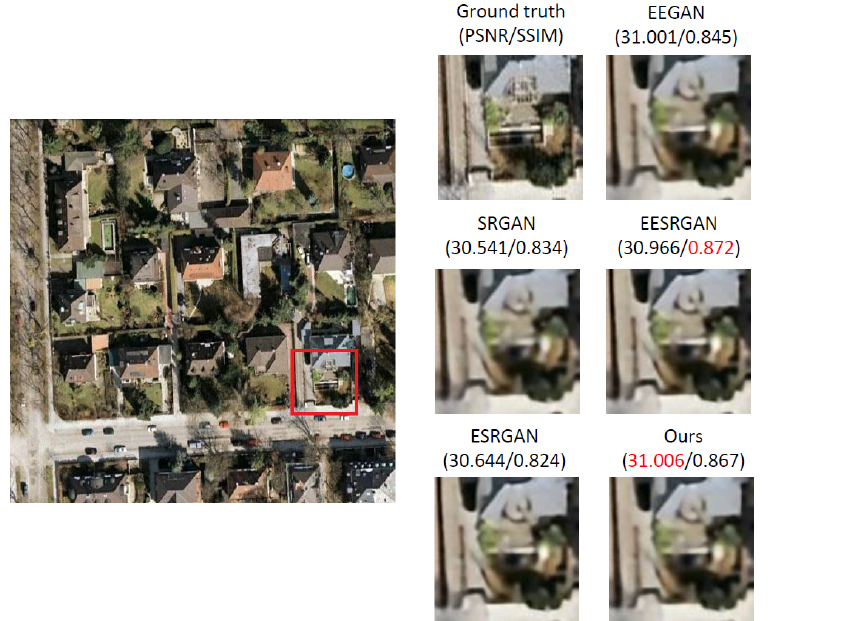
Figure 12. An enlarged partial view of the SR result of each method in the WHU-RS19 dataset, where the best results are shown in red